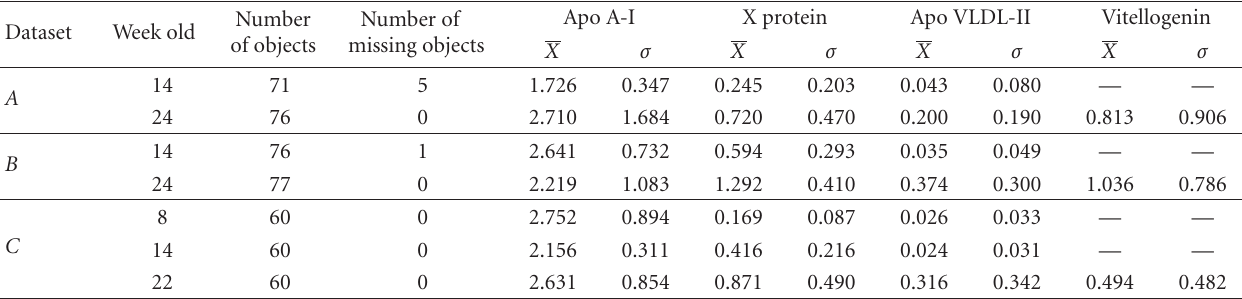
Table 4: A basic statistical analysis for the serum protein concentrations for the A , B , and C dataset. Dataset